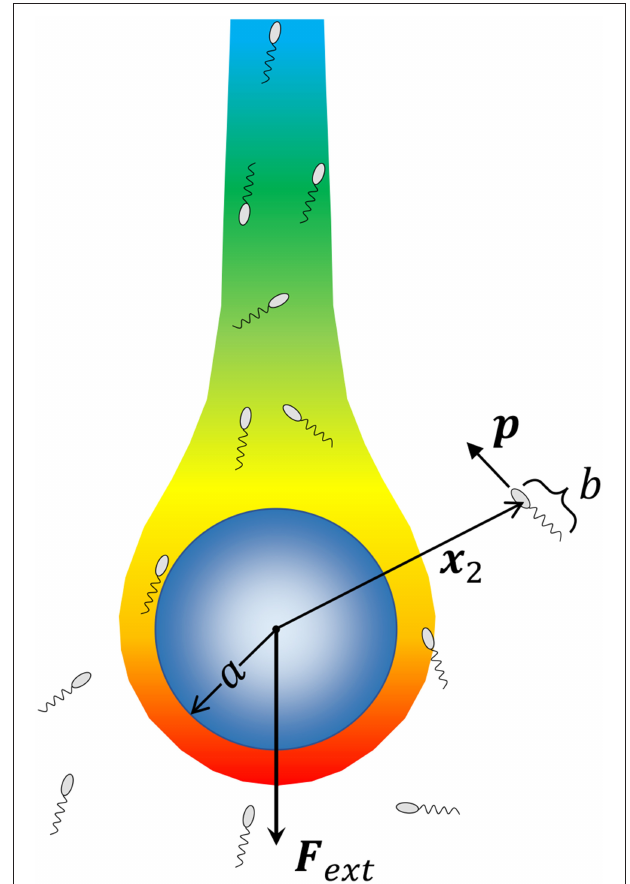
FIGURE 1 | A schematic of the problem being solved. A marine snow aggregate of radius a sinks under the influence of an external force (gravity) F ext . A chemoattractant emanates from the surface of marine snow, and forms a plume “behind” the marine snow. We consider a system of N b bacteria (of size b ) that are not interacting with each other but can perform chemotaxis toward nutrient hot-spots (the concentration boundary layer and the plume around the aggregate), and interact hydrodynamically with the aggregate upon encountering it. We consider the motion of each bacterium by simulating its trajectory, i.e., the time evolution of its position with respect to the aggregate x 2 , and its orientation p , as dictated by hydrodynamic